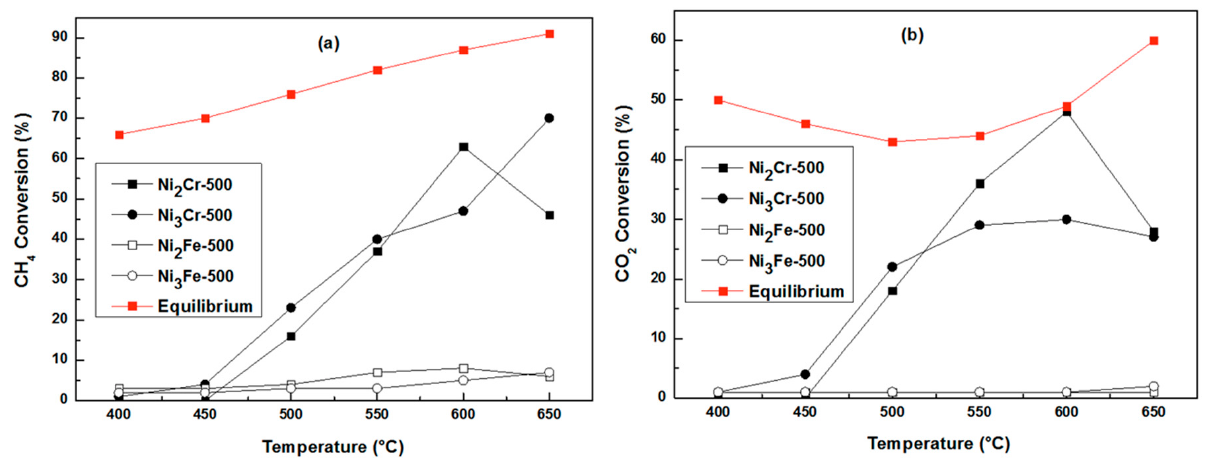
Figure 10. CH 4 ( a ) and CO 2 ( b ) conversions obtained on the fresh Ni R M-500 (M = Cr or Fe, R = 2 or 3) catalysts issued from LDH structure and calcined at 500 °C (CH 4 = 20%; CO 2 = 20%; 100 mg; F = 100 mL/min).